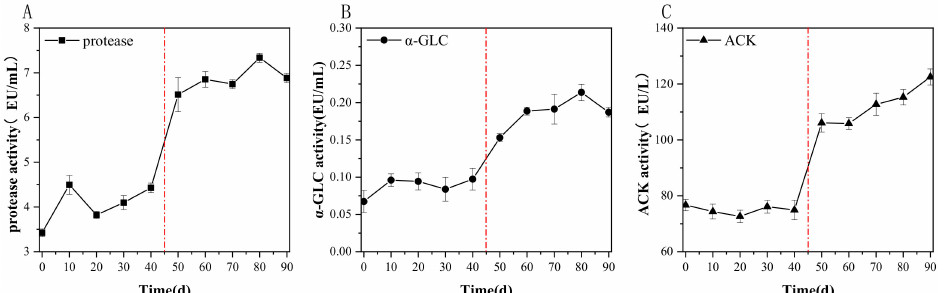
Figure 4. Influence of the MF membrane separation on enzymatic activities ( A ) protease; ( B ) α -GLC; ( C )